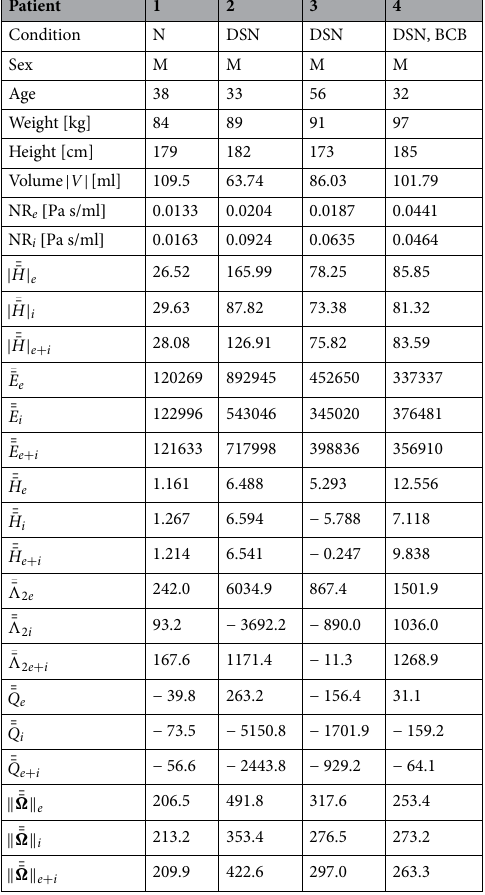
¯¯| H | —absolute helicity;